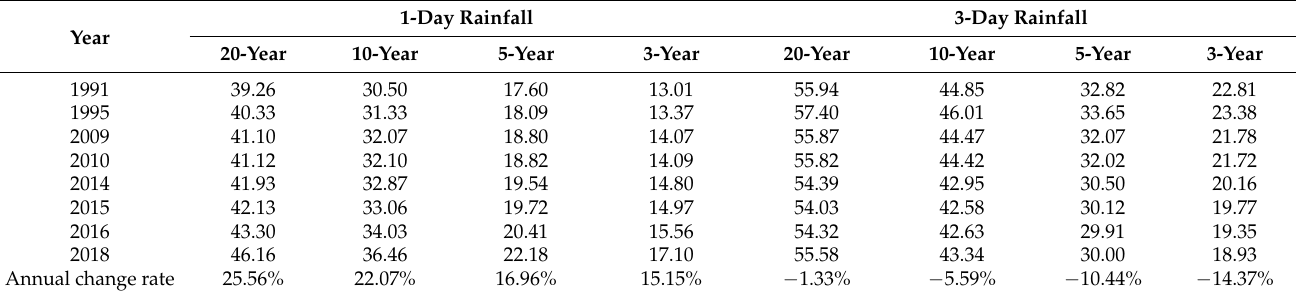
Table 2. Theoretical runoff under 1-day and 3-day rainfall with different return periods